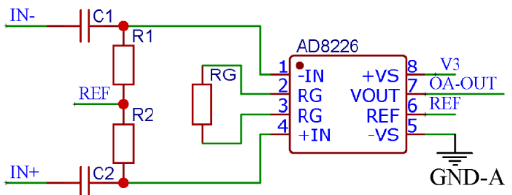
Figure 9. Circuit diagram of differential amplification of the turbulence sensor signal.